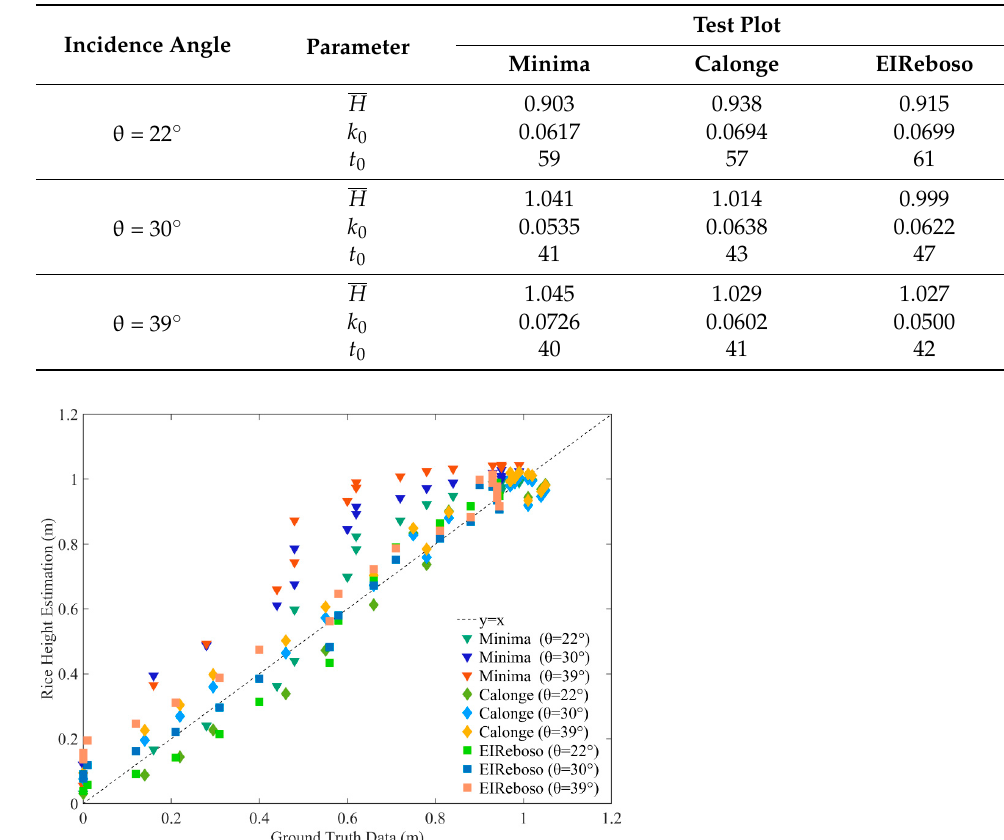
Test Plot Minima Calonge EIReboso